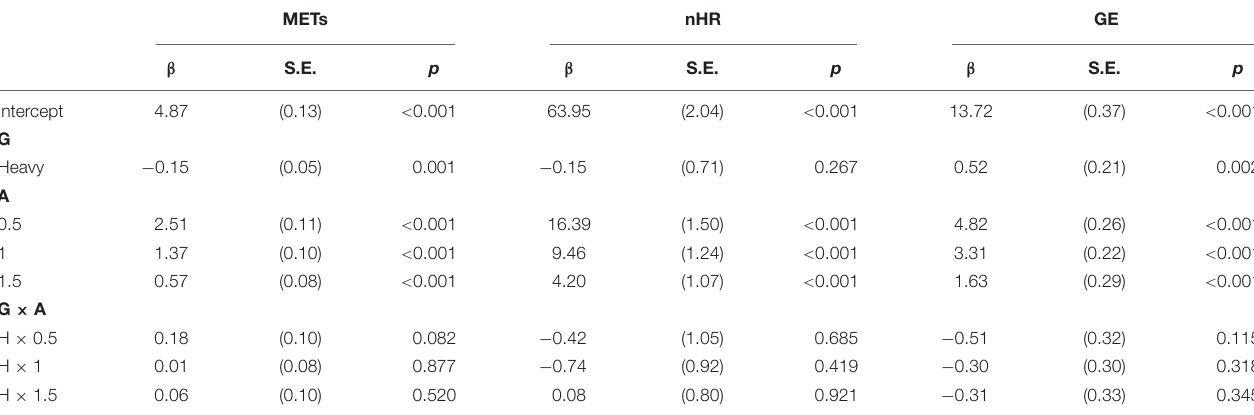
TABLE 1 | Coefficients ( β ), standard errors (S.E.) and p values of physiological responses in 1.0% slope conditions. METs nHR GE